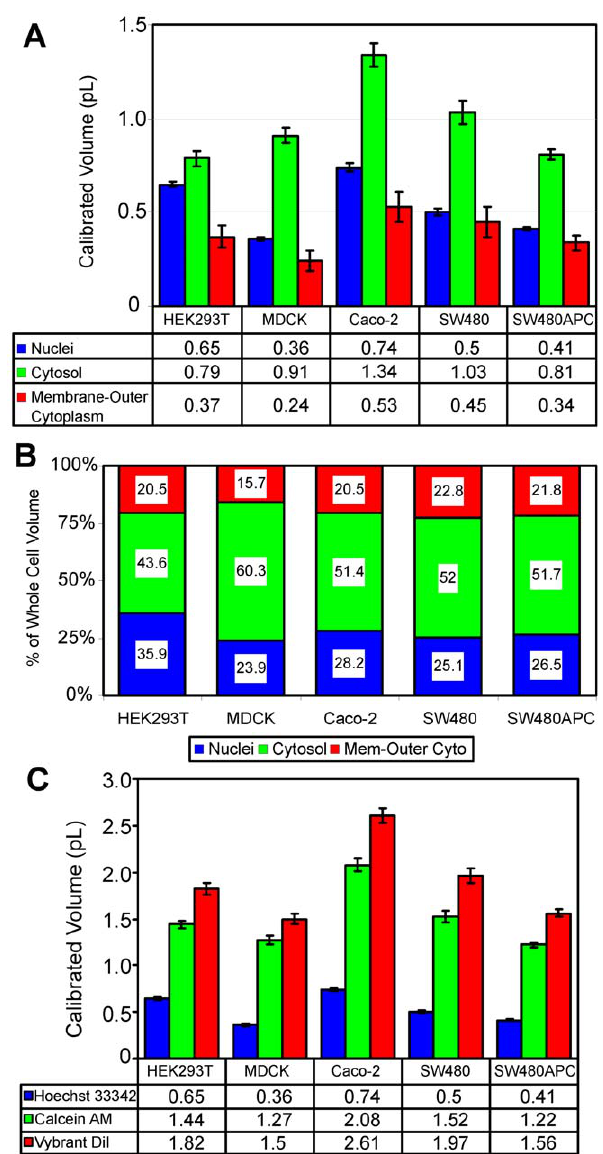
Figure 4. Cell volume measurement statistics for non-dividing cells. Fluorescent marked and calculated compartment volumes and distribution results showing (A) calibrated cell compartment volumes in pL, (B) distribution of compartment volume (% of total) and (C) fluorescent marked volumes in pL for non-dividing cells.